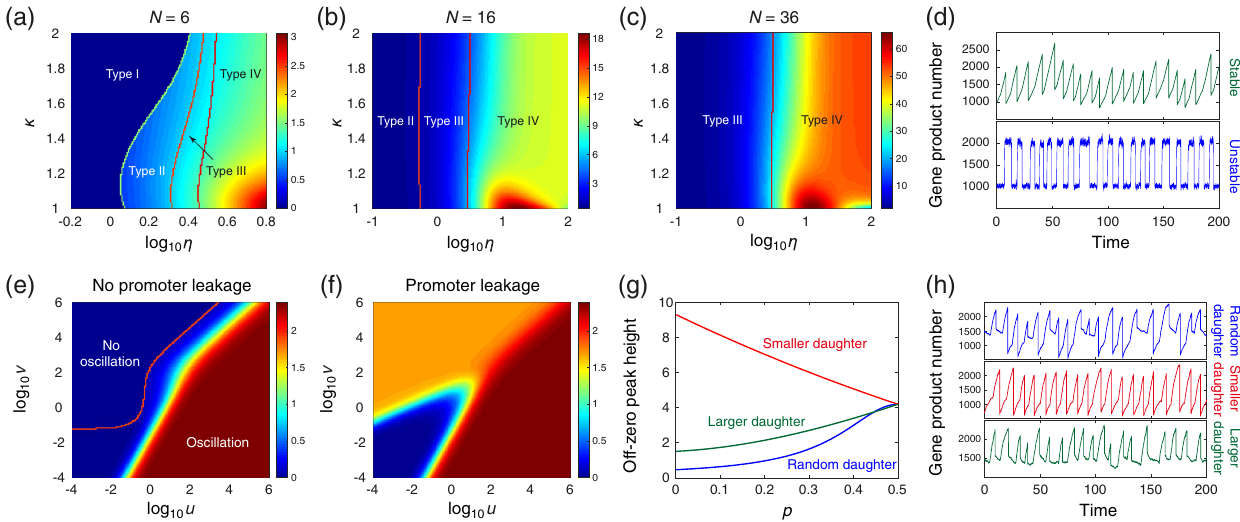
FIG. 3. Further properties of the power spectrum. (a) – (c) Heat maps showing the dependence of the height of the off-zero peak (relative to the zero peak) on the parameters controlling gene product stability ( η ) and dosage compensation ( κ ). For stable gene products with η ≪ 1 , it is only possible to observe type I – III spectra; type IV can be produced by unstable gene products with η ≫ 1 . Strong dosage compensation ( κ ¼ 1 ) in (b),(c) leads to maximal oscillation regularity at an intermediate gene product stability. (d) Typical trajectories for stable and unstable gene products. With the same gene expression mean, unstable products lead to more robust sustained oscillations than stable ones. (e) Heat map showing the dependence of the height of the off-zero peak (relative to the zero peak) on promoter switching rates u and v in the absence of promoter leakage. (f) Same as (e) but in the presence of promoter leakage. Fast promoter switching, leakage, and active gene-state dominance enhance oscillation regularity. (g) Height of the off-zero peak (relative to the zero peak) versus the asymmetric allocation probability p for three types of tracking protocols at cell division: tracking one of the two daughters randomly (blue), tracking the smaller daughter (red), and tracking the larger daughter (green). (h) Typical trajectories for the three protocols generated using Gillespie ’ s algorithm. Note that (a) – (c) and (e) – (g) are obtained from numeric evaluation of Eq. (9). See Sec. S6 in the Supplemental Material [66] for the technical details of this